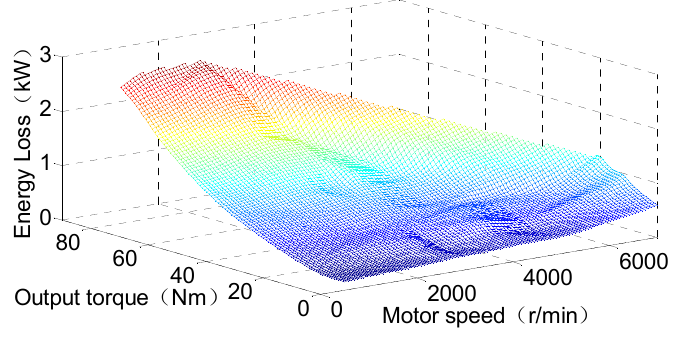
Figure 4. Energy loss vs . motor speed and output